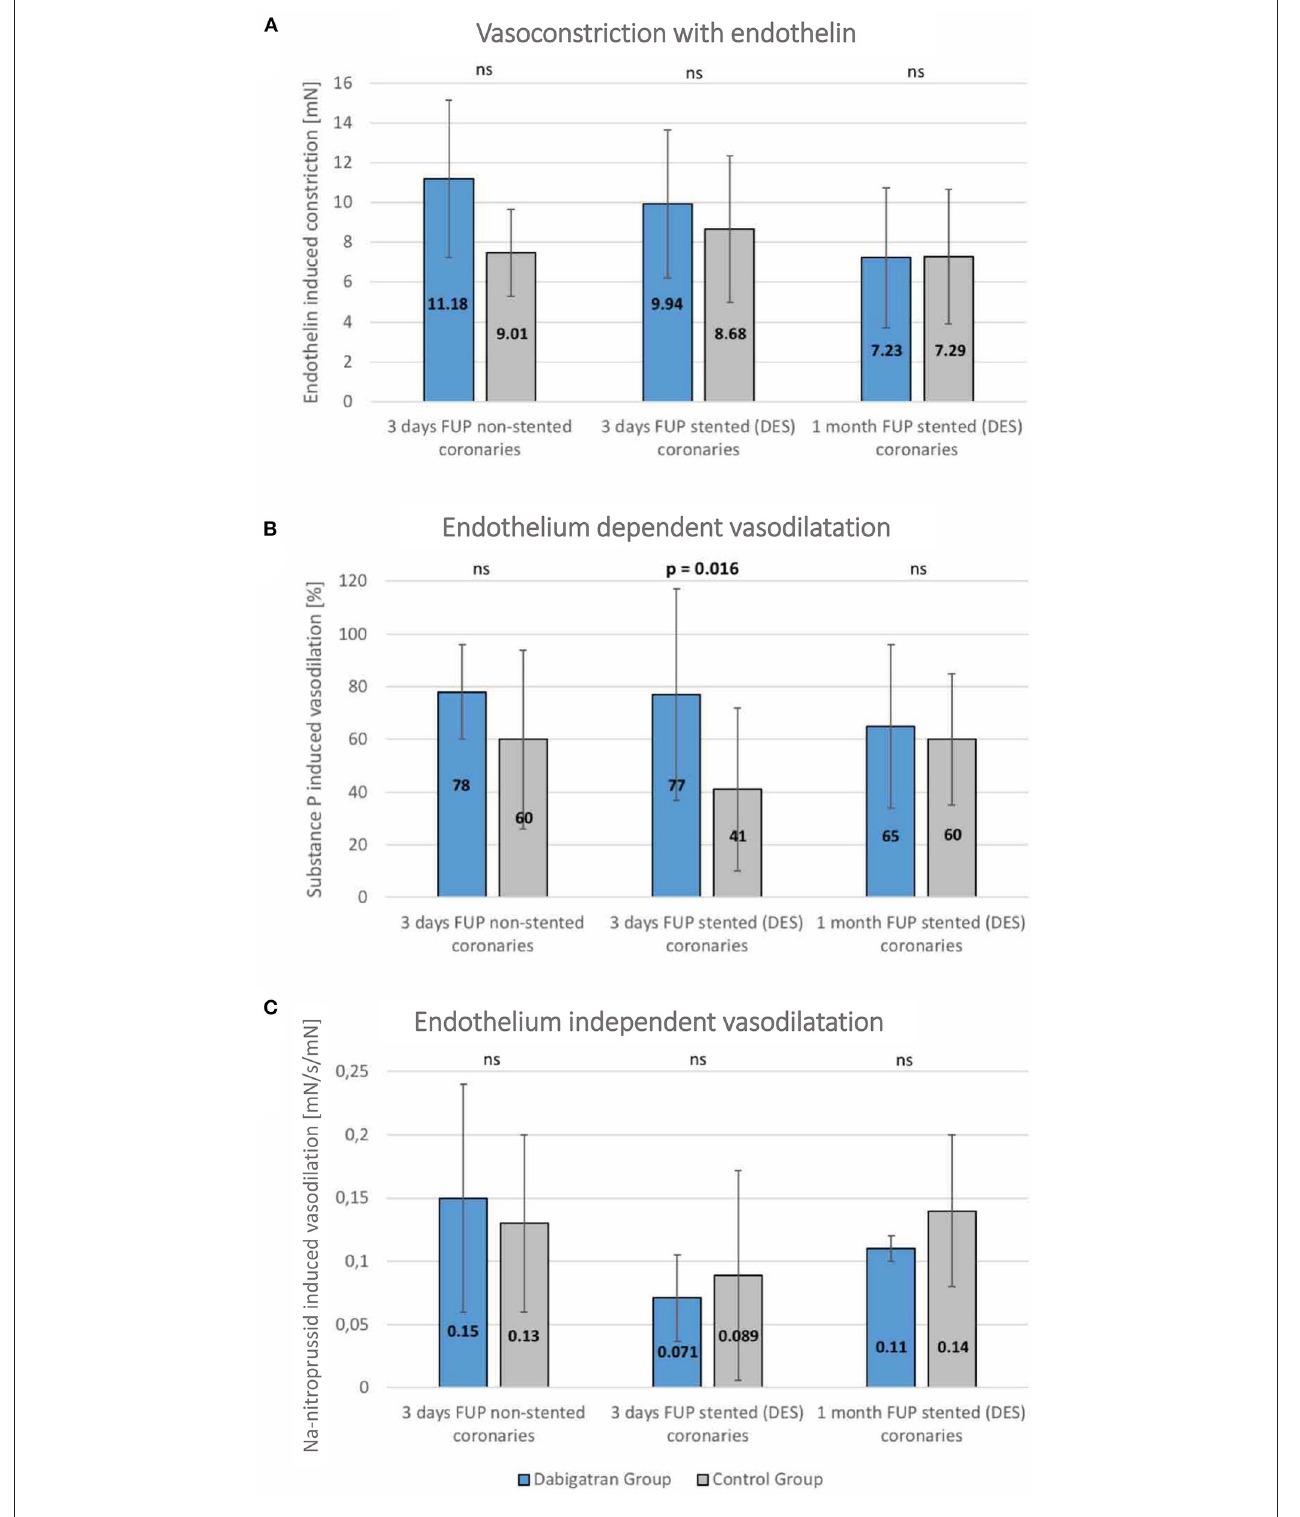
FIGURE 3 | Vasomotor diagrams of stented and non-stented coronary arteries in dabigatran and control groups. (A) Endothelin-induced vasoconstriction, (B) Endothelium-dependent vasodilation, (C) Endothelium-independent vasodilation in non-stented (native right coronary artery) and stented (summed results of left anterior descendent/LAD/and left circumflex/LCx/) coronary arteries at 3 days post stenting, and at the 1-month follow-up. No statistically significant differences between the groups. Significantly enhanced endothelium-dependent vasodilation capacity at the 3-day follow-up in dabigatran group. Mean ± SD.